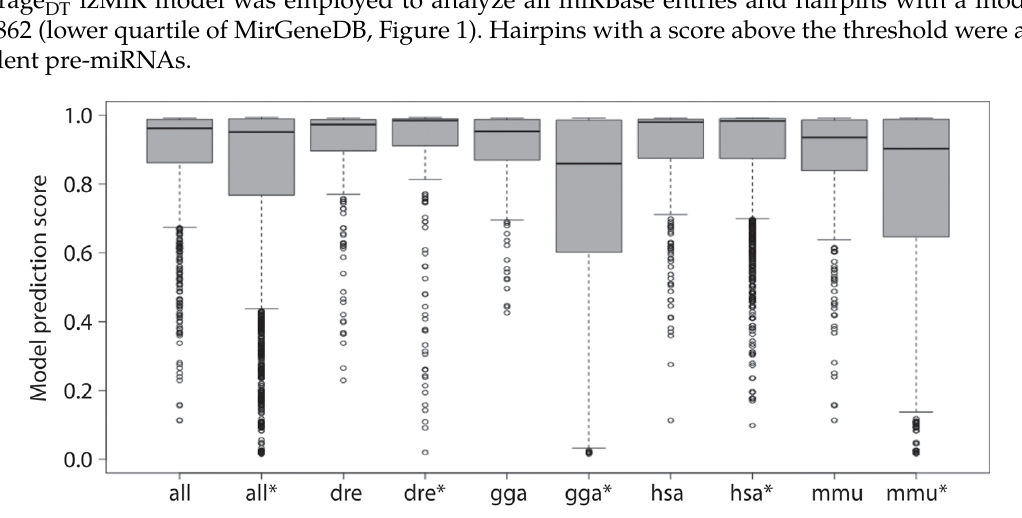
Figure 1: The model score distributions of all species in MirGeneDB individually and combined and their miRBase coun- terparts (miRBase indicated with *). From left to right, the number of pre-mirNAs supporting the distributions are: 1434, 4160, 229, 740, 395, 1193, 523, 1881, 287, and